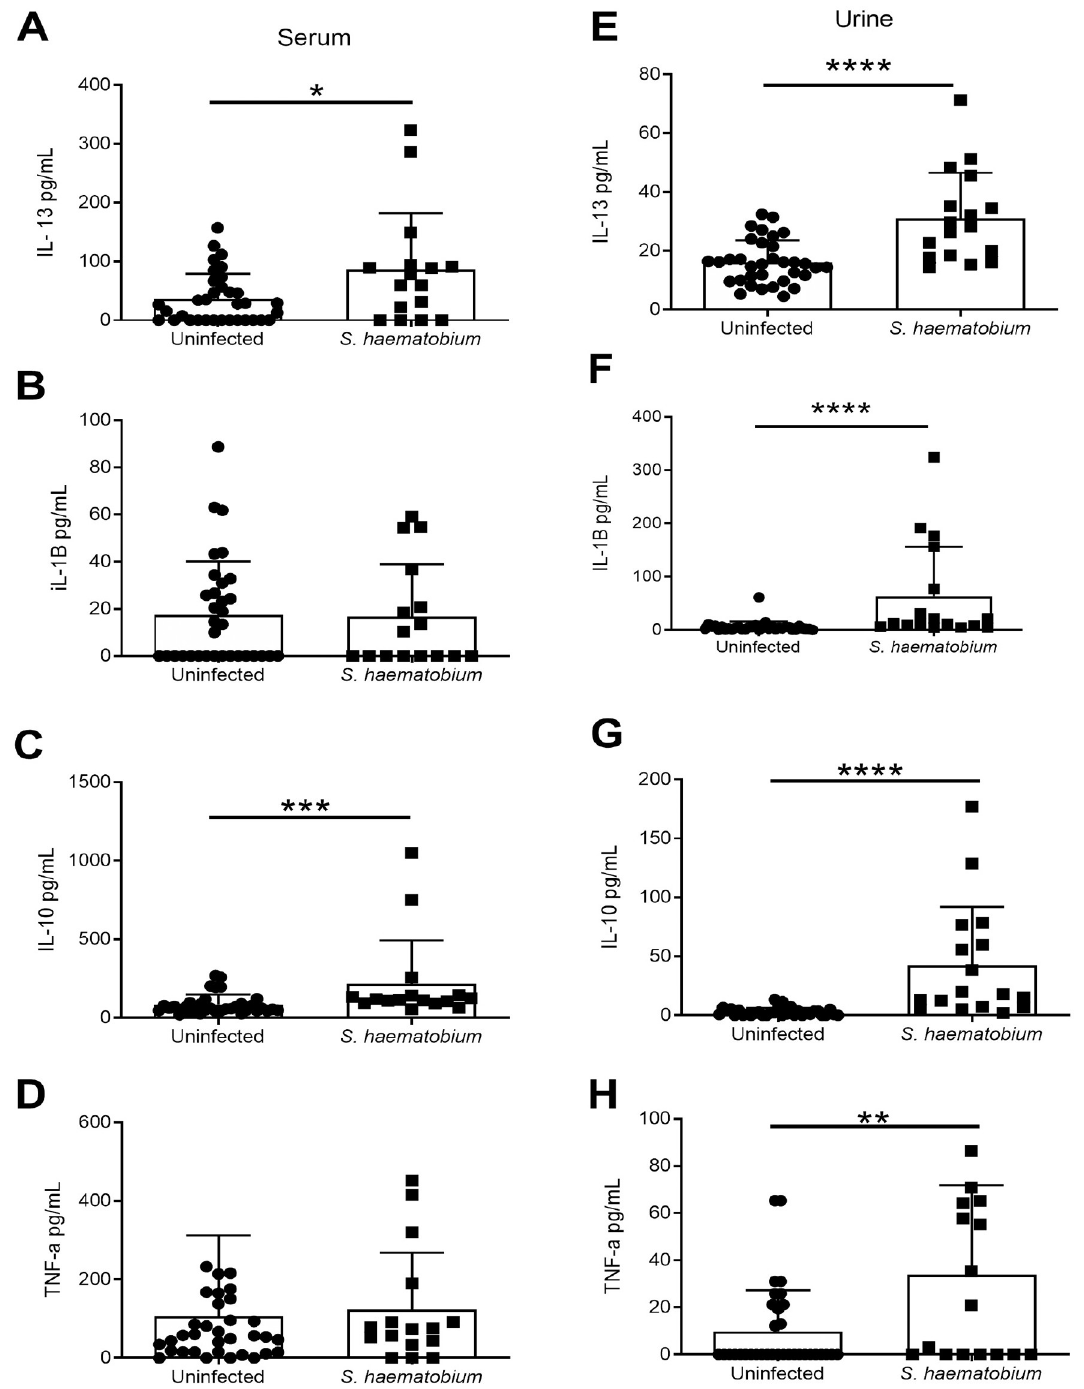
Fig 5. Cytokine (IL-13, IL-1b, IL-10, and TNF- α ) levels in serum or urine samples of Nigerian children infected with or without S . haematobium . (A-D) Serum levels and (E-H) urine levels of (A, E) IL-13, (B, F) IL-1b, (C, G) IL-10, and TNF- α (D, H) were measured in infected (n = 16–17) and uninfected (n = 34) children. � p < 0.05, �� p < 0.01, ��� p < 0.001, ���� p < 0.0001.